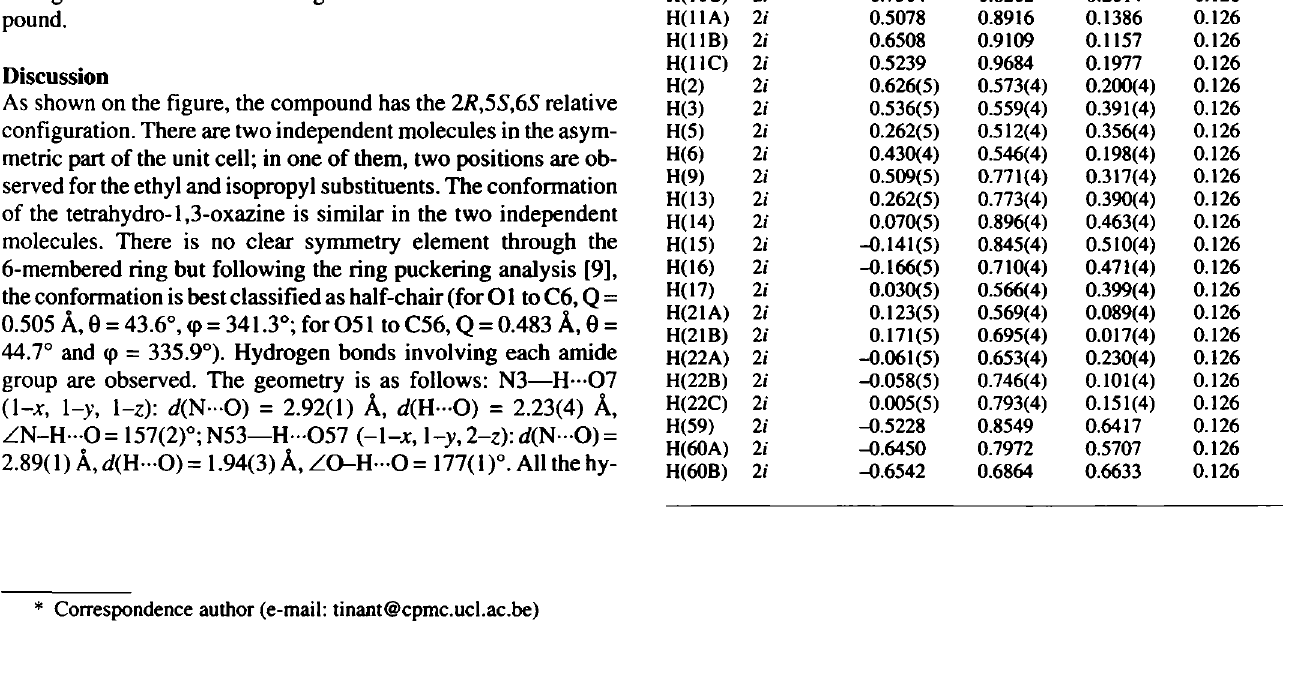
Table 2. Atomic coordinates and displacement parameters (in A 2